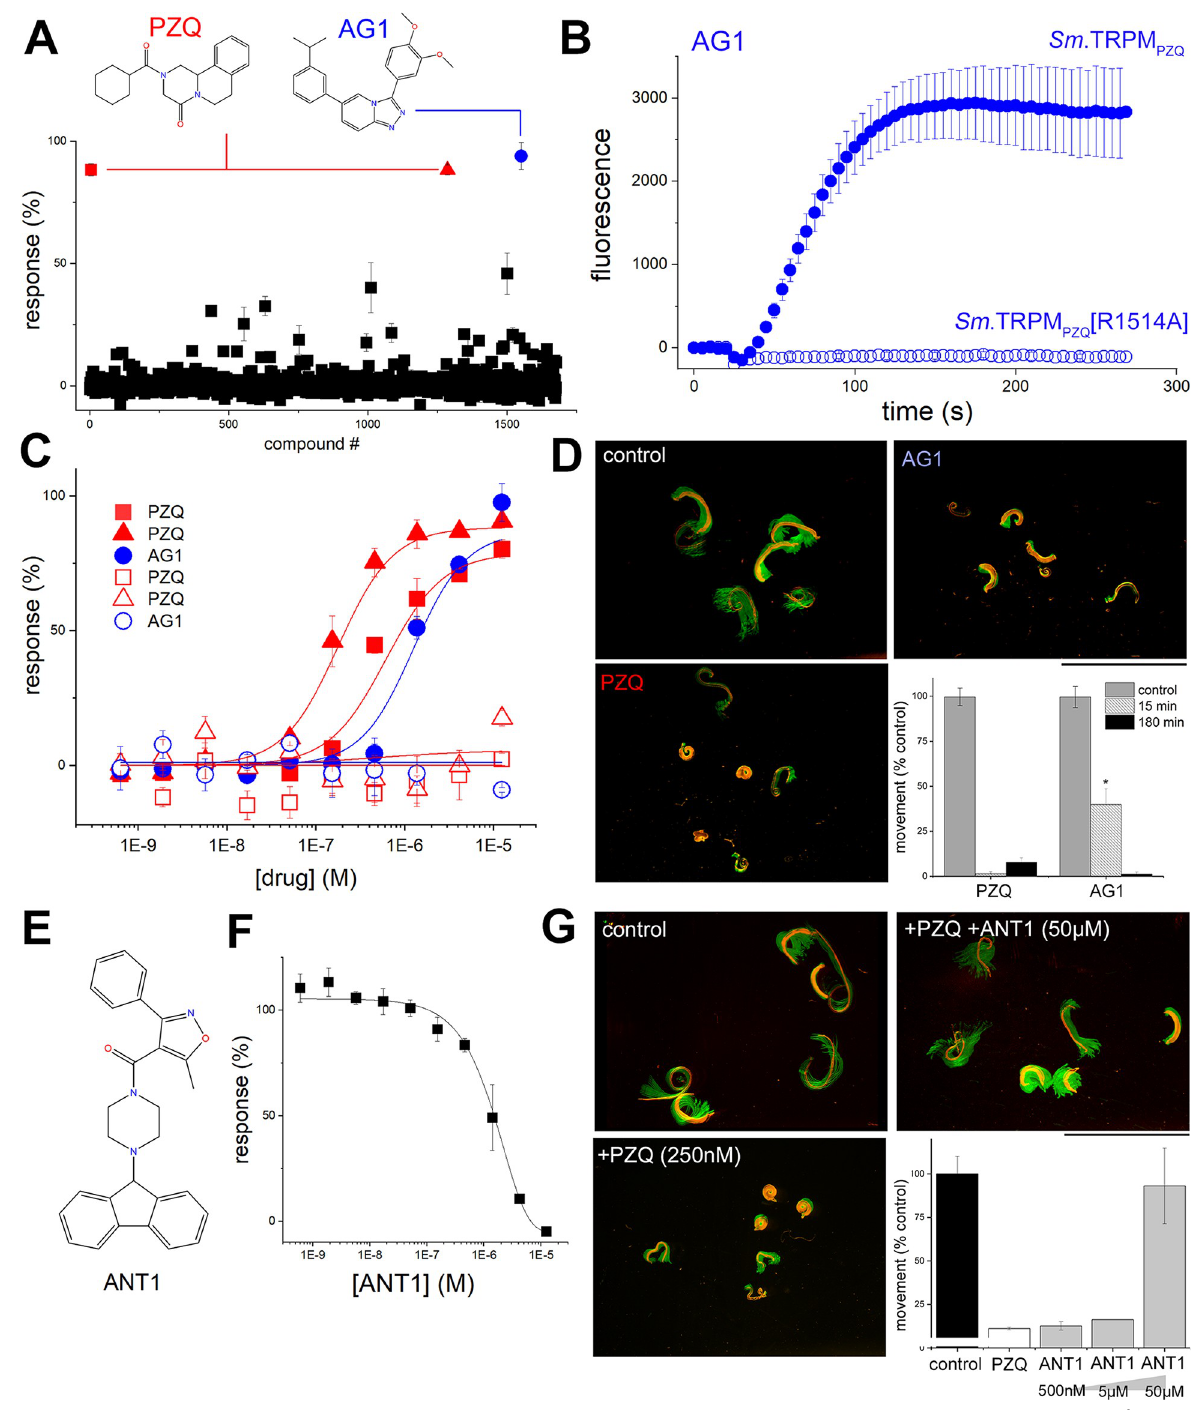
Fig 4. Identification of new chemotypes active at Sm .TRPM PZQ . ( A ) Primary screen of Sm .TRPM PZQ in agonist mode measuring peak Ca 2+ signal amplitude in response to 1,678 compounds (LOPAC 1280 , Pathogen Box) tested at 5 μ M final concentration. Structures of ‘hits’ (PZQ, red; AG1, blue) are shown. ( B ) Kinetics of a response of wild-type Sm .TRPM PZQ to AG1 (30 μ M, closed circles), or the binding pocket mutant Sm . TRPM PZQ [R1514A] to AG1 (open circles). ( C ) Analysis of the three primary screen hits via full concentration response curves for PZQ (compounds #5, #1287) and AG1 (compound #1552) in HEK293 cells transiently transfected with Sm .TRPM PZQ (solid symbols) or untransfected controls (open). Data represent mean ± sd of triplicate samples. ( D ) Images of adult schistosome worms with single frame image (red) overlayed with maximum intensity projection (green) of a time-lapse series to illustrate worm movement and effects of PZQ (500 nM) and AG1 (1 μ M) on worm